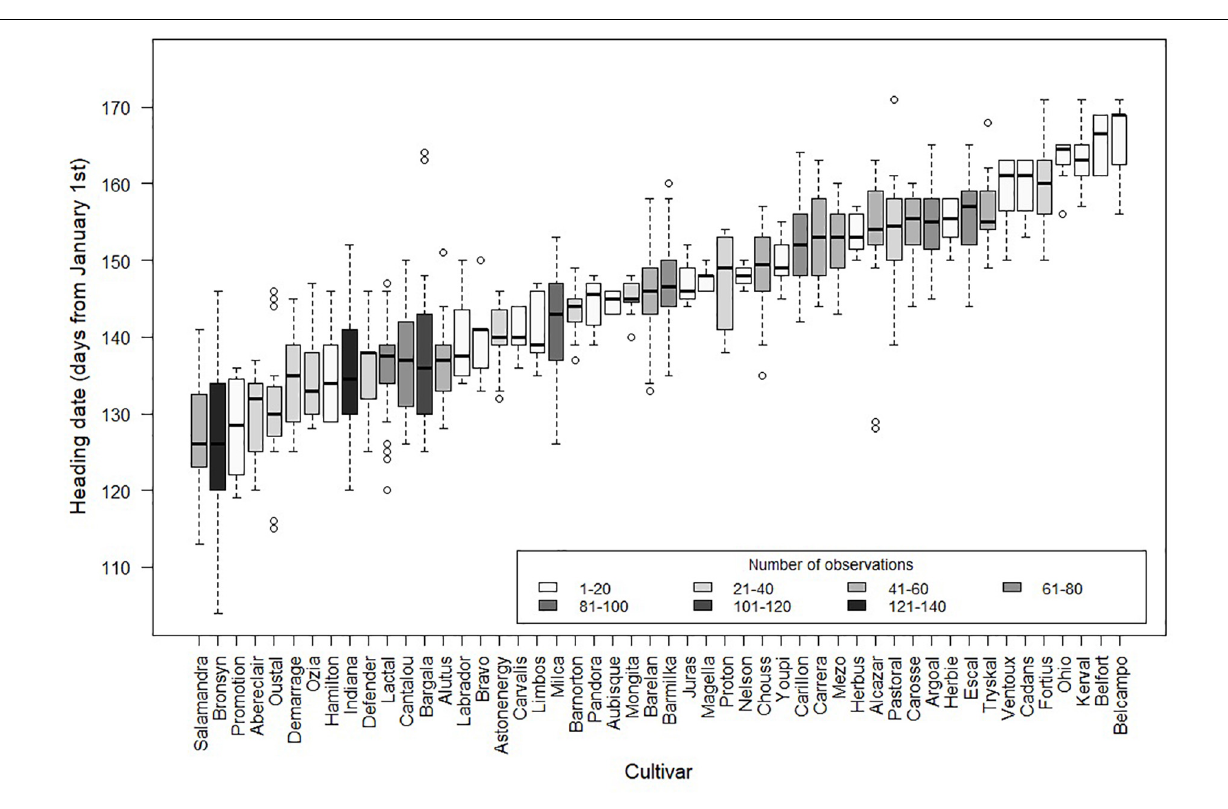
development of grasslands at canopy, plant and apex